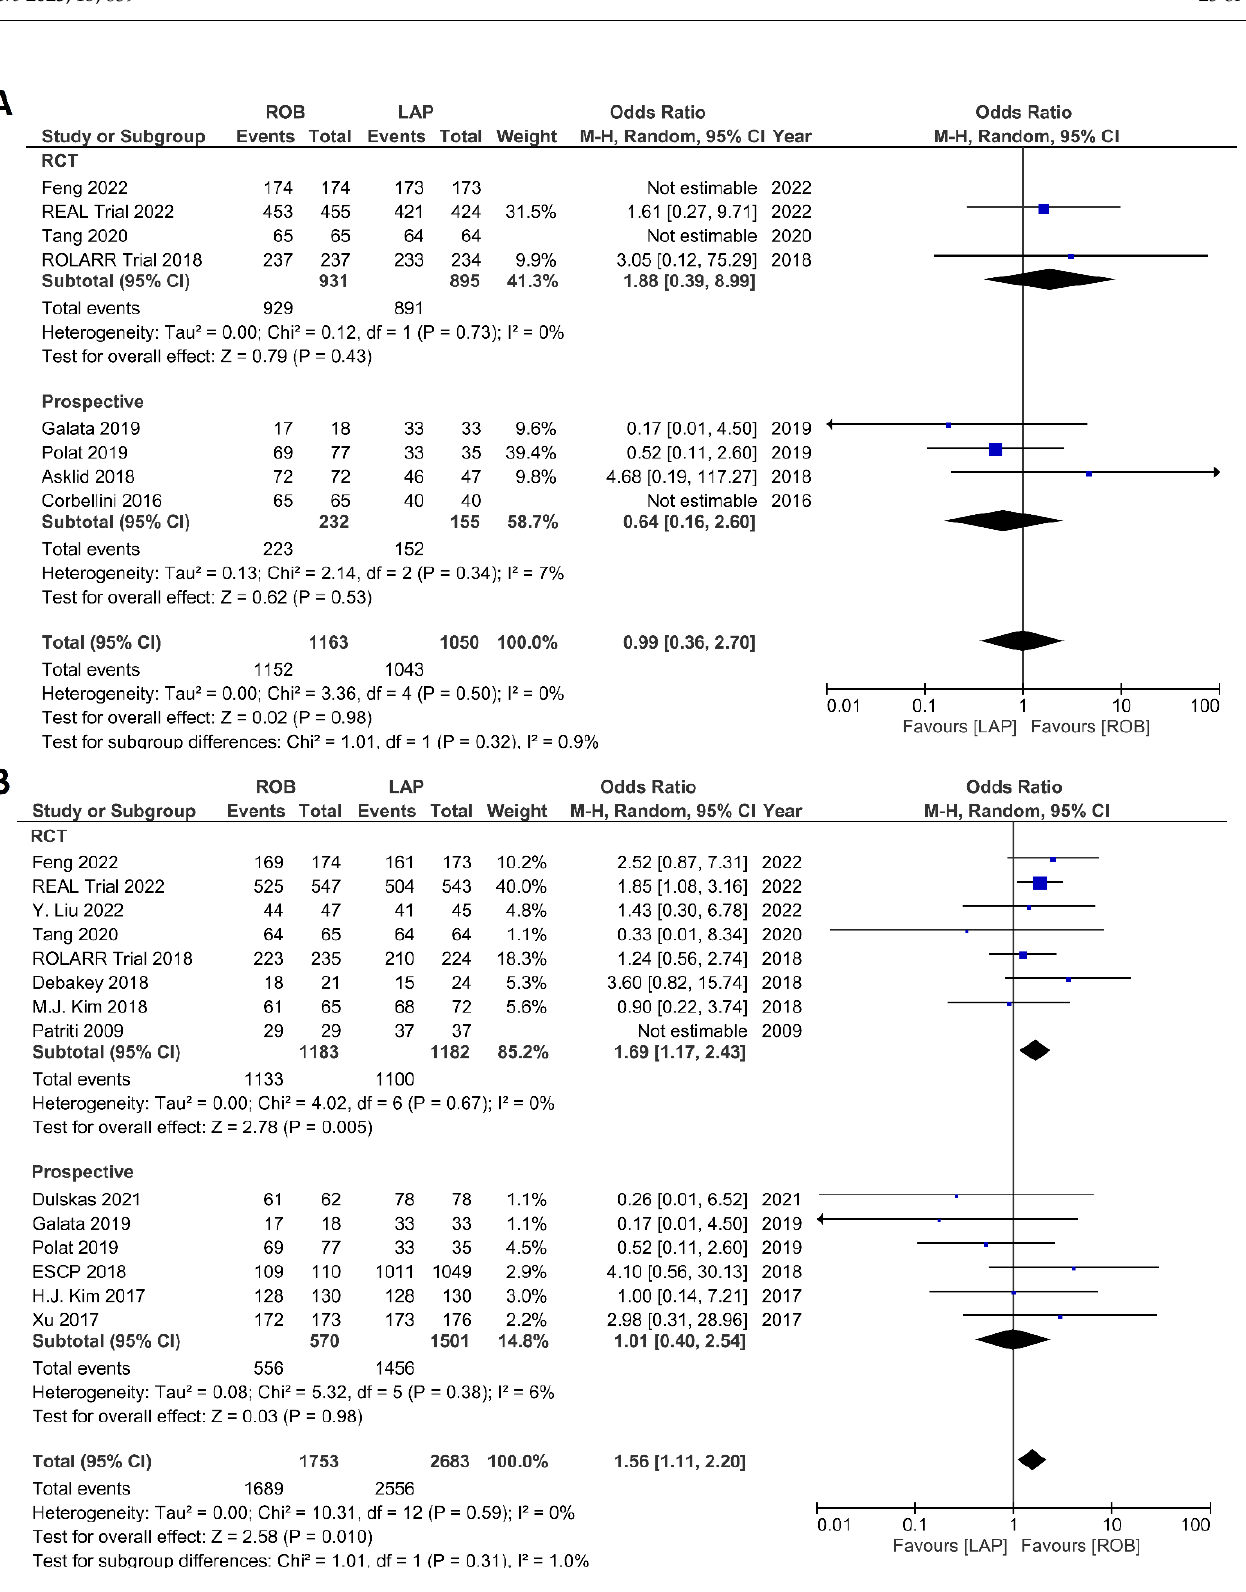
Figure 12. Forest plots comparing ( A ) microscopic margin-free resection (R0 resection) [18,19,23,34,41,42,45,48,52] and ( B ) circumferential resection margin (CRM) [17,19,23,34,35,37,40 – 44,47 – 49,52] between robotic and laparoscopic rectal resection (blue boxes representing odd ratios, arrows representing 95% confidence intervals, and diamonds representing point estimates of pooled odd ratios or mean differences).